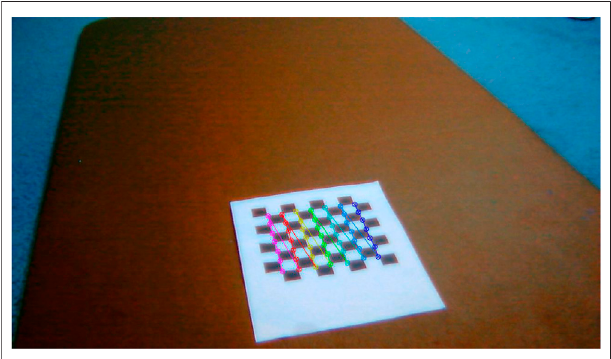
FIGURE 2 | Checkerboard corner points for the left camera (camera 2).